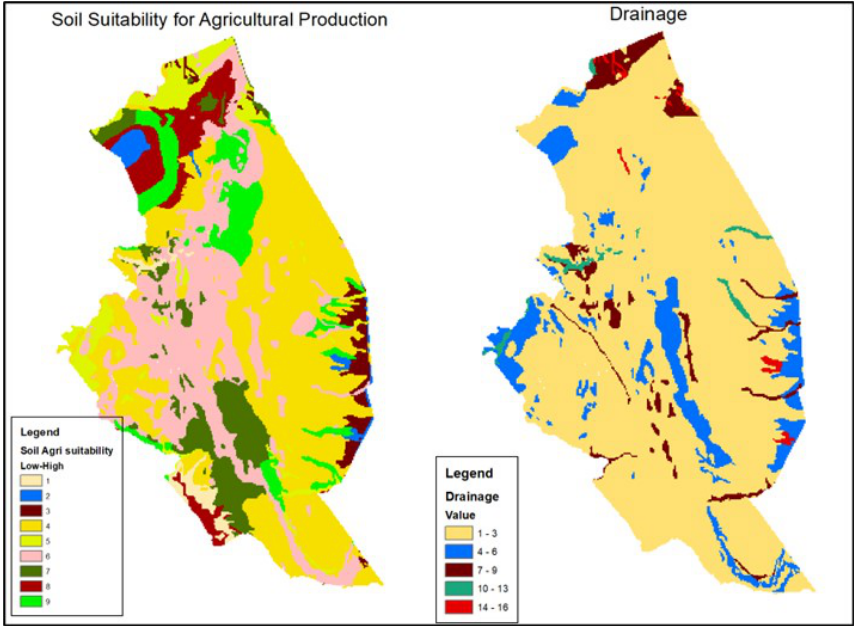
Figure 9. Soil suitability for agricultural production and